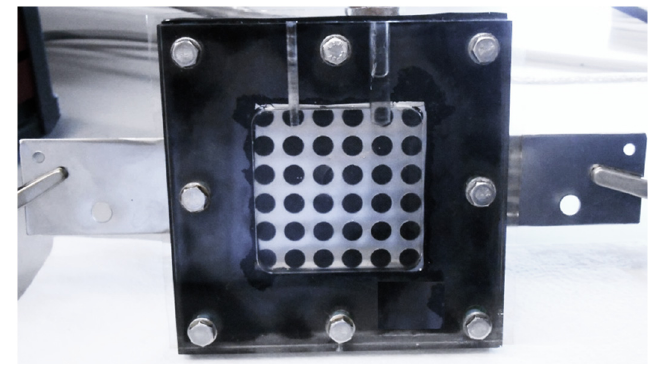
Figure 1. “In-house” passive direct methanol fuel cell (DMFC).